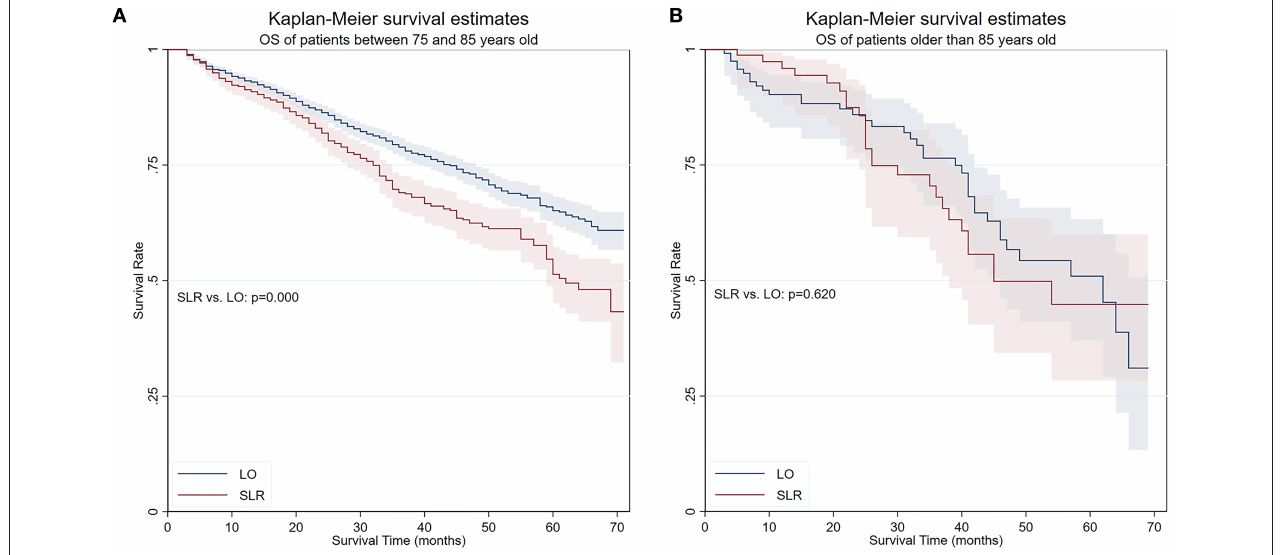
FIGURE 3 | OS of patients in two age groups. (A) OS of patients between 75 and 85 years old. (B) OS of patients older than 85 years. OS, overall survival; SLR, sublobar resection; LO, lobectomy.